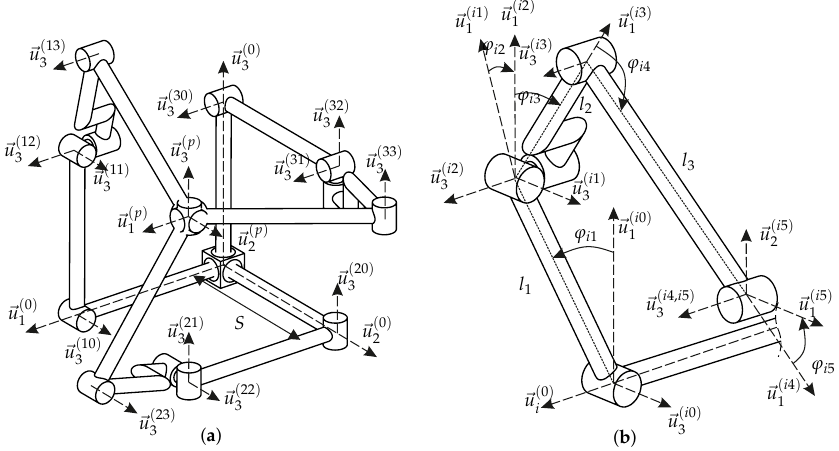
Figure 1. Kinematic sketches of the R-CUBE mechanism: ( a ) The manipulator, ( b ) variables of i th serial chain where i is one of the serial chains.